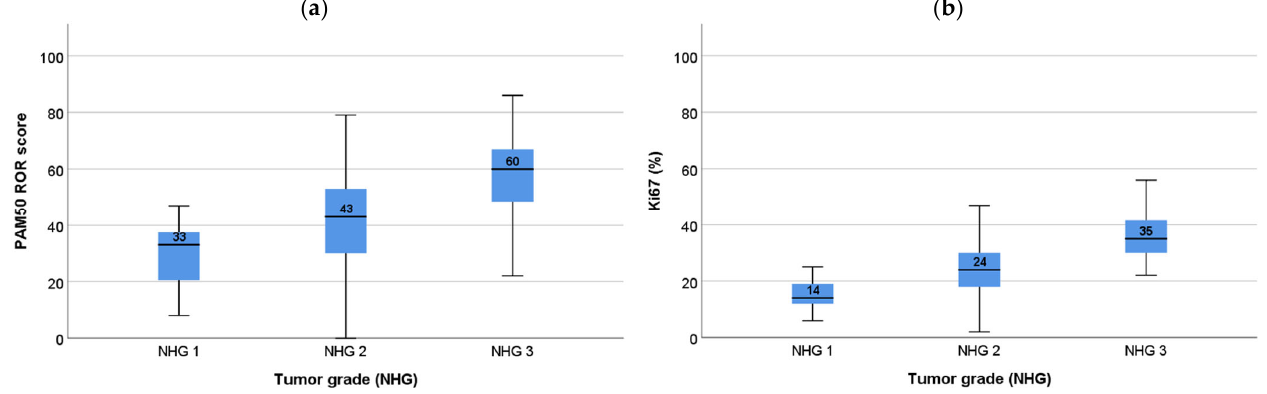
Figure 3. ROR and Ki67 in tumor grade; ( a ) Risk of recurrence score (ROR) versus Nottingham Histologic Grade (NHG). Mann–Whitney NHG 1 vs. NHG 2 p = 0.031; NHG 1 vs. NHG 3 p < 0.001; NHG 2 vs. NHG 3 p < 0.001; ( b ) Ki67 (%) versus NHG. Mann–Whitney p < 0.001 between all groups.